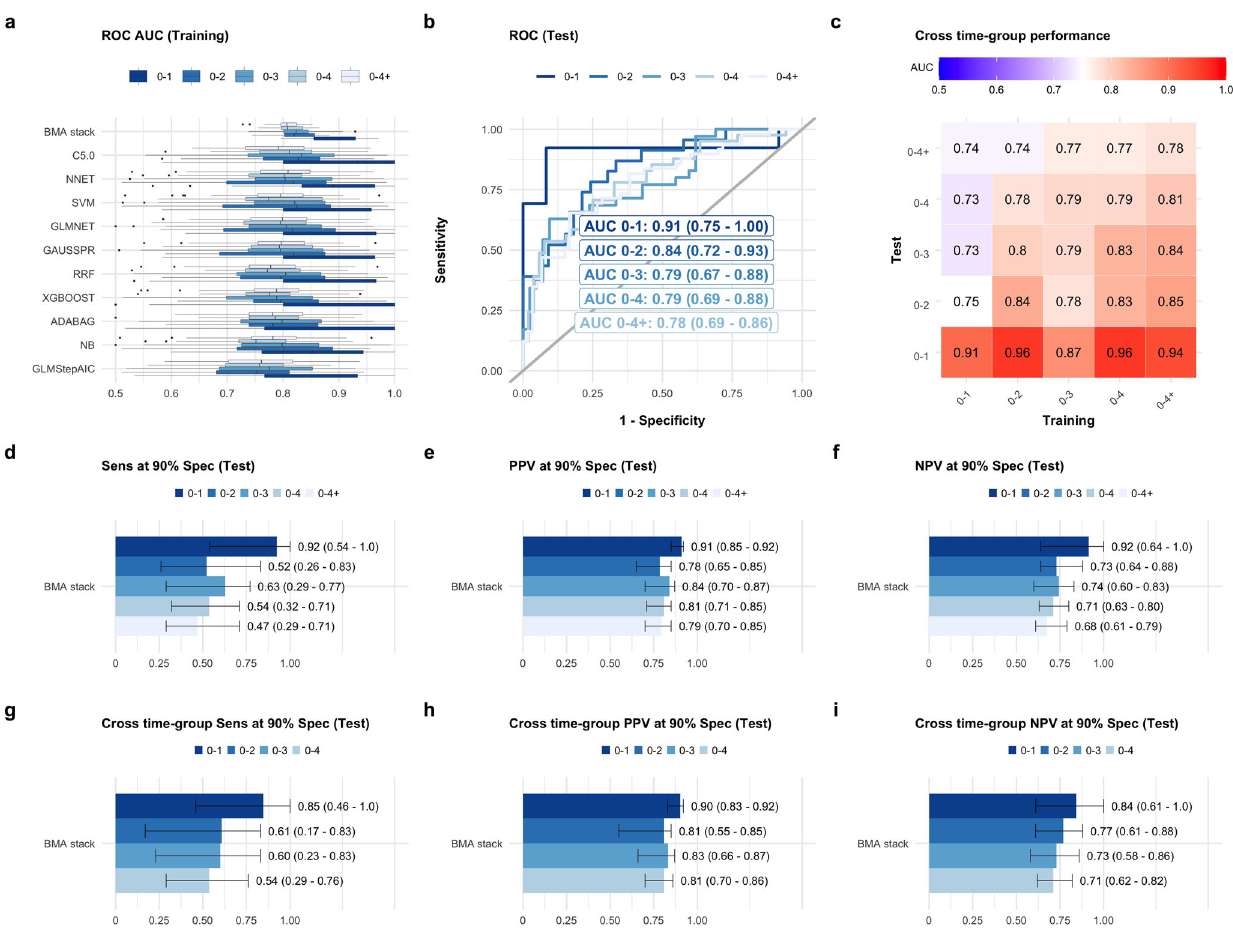
Fig. 1 Ensemble model performance per joined/combined time-group. a Distribution of receiver operating curve (ROC) area under the curve (AUC) across training folds for each of the base-learners and the Bayesian Model Averaging (BMA) stack meta-learner (Joined Time Group 2 Layer (JTG2L) model, see ‘ Methods ’ section on statistical analysis). See also Supplementary Figs. 24, 25 to 28 for alternative stacking methods. b ROC curves in the test set for the BMA stack per joined time-group. AUC 95% Con fi dence Intervals (CI) were determined by strati fi ed bootstrapping. c Cross-time group performance of the BMA stack developed in the training set and evaluated in speci fi c time-groups in the test set. 95% CI for AUCs are not shown but the predictions were all signi fi cant. d Sensitivity (Sens), e Positive predictive value (PPV) and f Negative predictive value (NPV) at 90% Speci fi city (Spec) corresponding to b . g – i Cross time-group performances for the ensemble trained in 0-4 + samples (last column in c ). See also Supplementary Fig. 29 for other stacking methods. For the Matthew correlation coef fi cients corresponding to d – i , see Supplementary Fig. 30. In a , b , d – i , shades of blue from dark to light correspond to results obtained in 0-1, 0-2, 0-3, 0-4 and 0-4 + years to diagnosis samples, respectively. The number of independent training samples was n = 107 (0-1), n = 180 (0-2), n = 252 (0-3), n = 309 (0-4) and n = 363 (0-4 + ). The number of independent test set samples was n = 26 (0-1), n = 60 (0-2), n = 82 (0-3), n = 98 (0-4) and n = 114 (0-4 + ). See Supplementary Table 12 for further details on case and control samples. See ‘ Statistical analysis ’ in Methods for further details and Supplementary Data 1 –